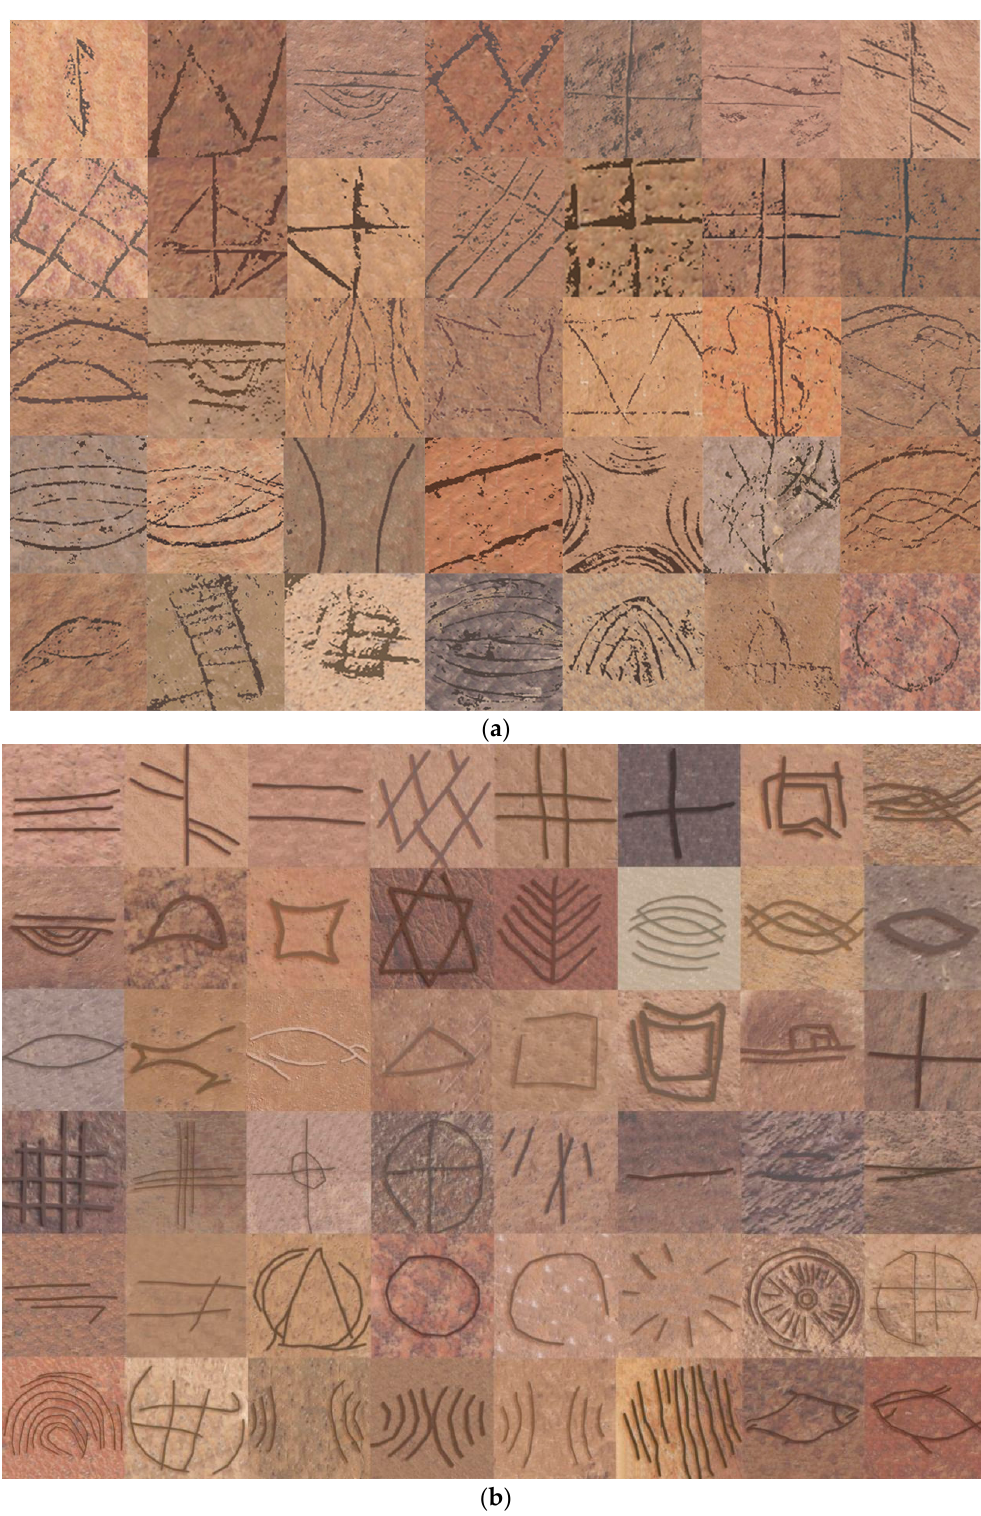
Figure 7. Images generated by various network models. ( a ) Images generated by the multi‑attention network; ( b ) images generated by the channel a tt ention network.